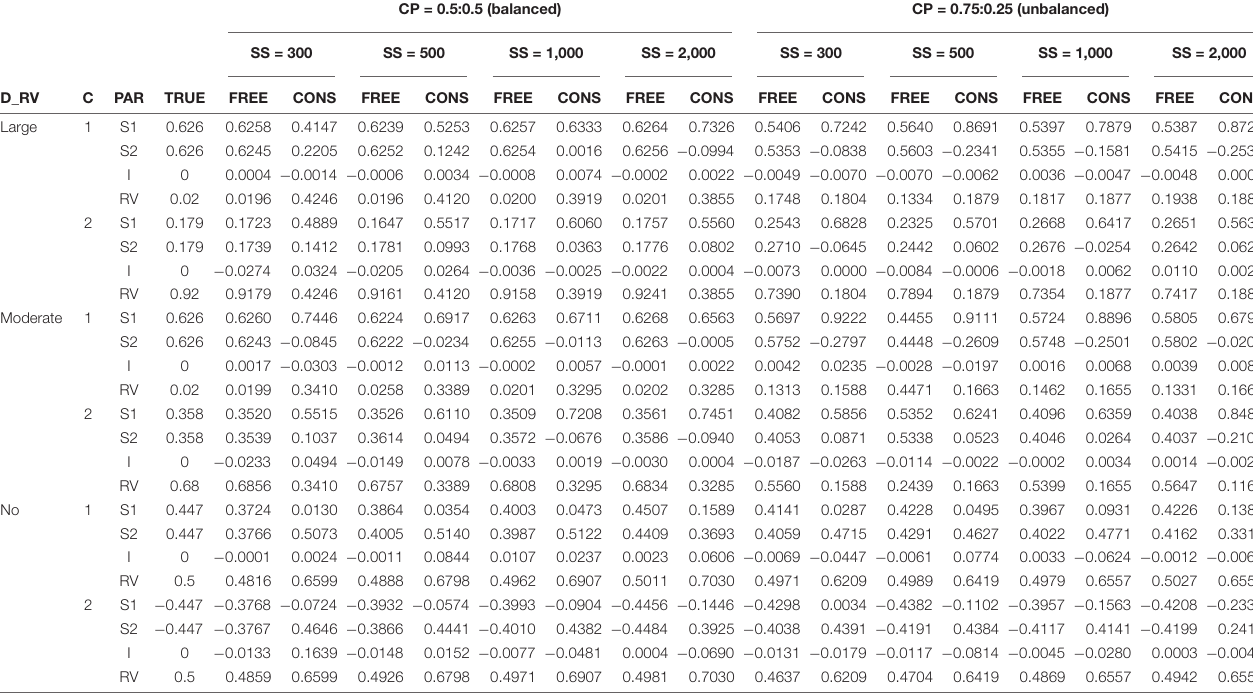
TABLE 5 | Parameter estimates of two-predictor models with no intercept difference.